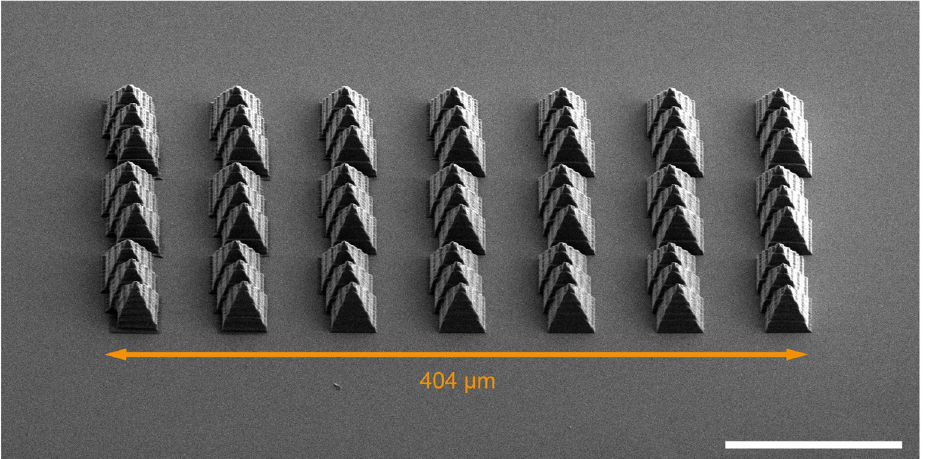
Fig 6. Writing of 3D structures. SEM view of an array of pyramids-like structure extending ~400 μ m along x written with three simultaneous polymerizing spot projected holographically with laser power/writing speed 59.4mW/20 μ m/s (estimated power density of 10.08TW/cm 2 per spot [23]). Scalebar is 100 μ m, sample is tilted by 45˚.